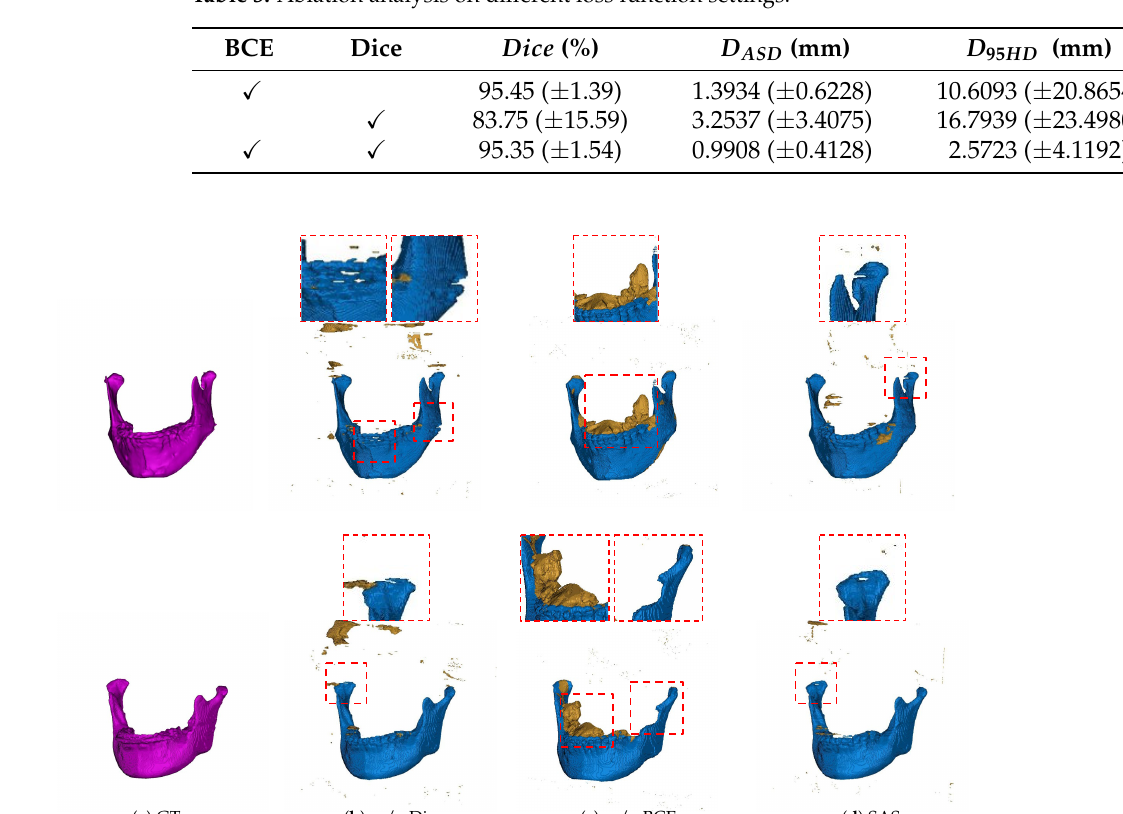
Figure 8. Results with different ablations of loss functions. The ground truth is shown in column ( a ). Columns ( b – d ) illustrate the segmentation results derived from the model without Dice loss, BCE loss and the proposed SASeg, respectively. The red rectangle indicates the zoom-in views of bad predictions. (w/o Dice: without Dice loss, w/o BCE: without BCE